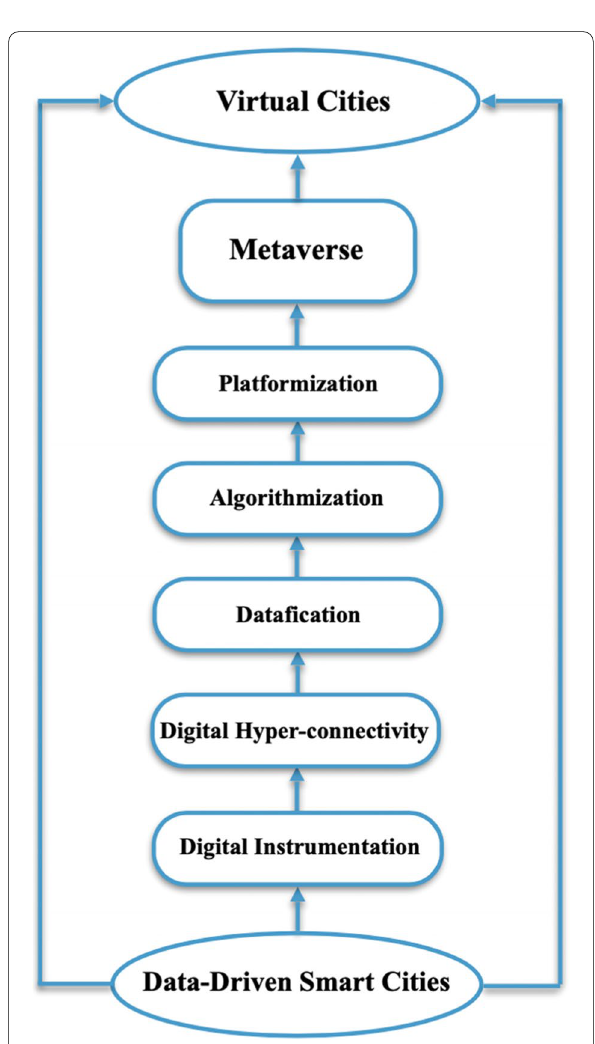
Fig. 1 A conceptual framework for the digital and computing processes underlying the Metaverse as a virtual form of data-driven smart urbanism